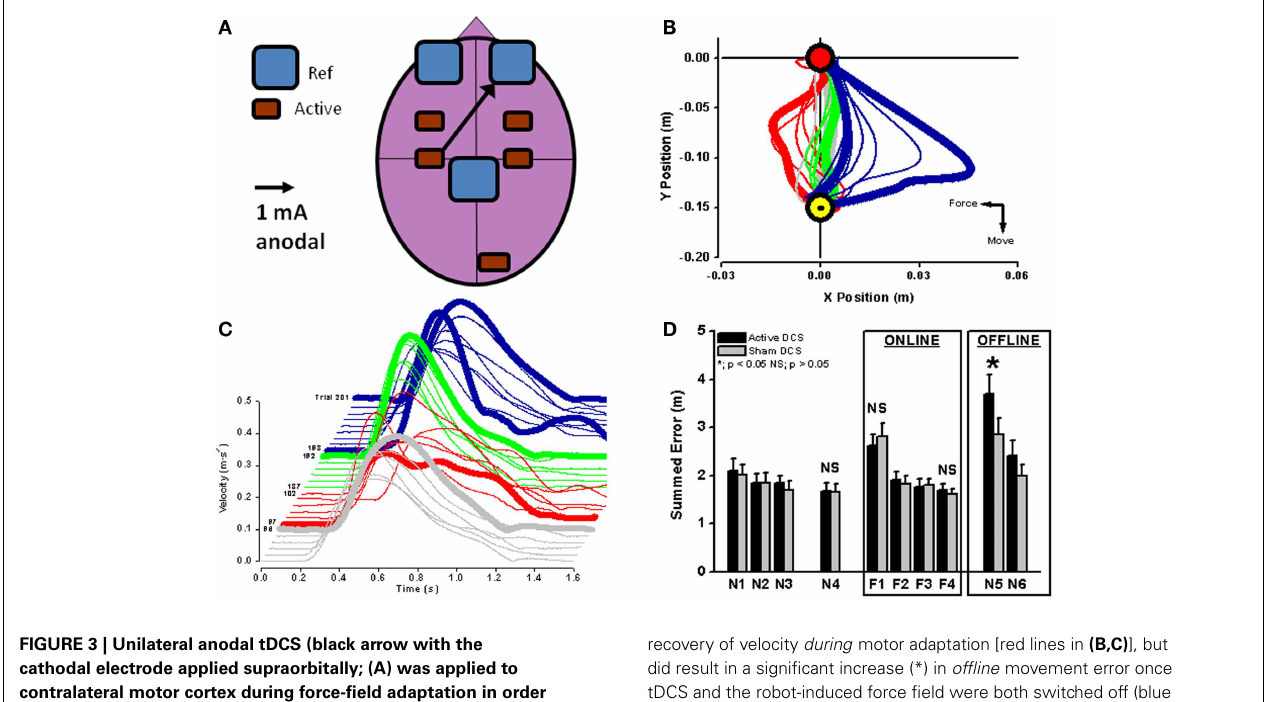
FIGURE 3 | Unilateral anodal tDCS (black arrow with the cathodal electrode applied supraorbitally; (A) was applied to contralateral motor cortex during force-field adaptation in order to augment ongoing neuroplastic changes in cortical neurophysiology (see Figure 2) . Interestingly, online tDCS stimulation did not change the reduction of movement error or